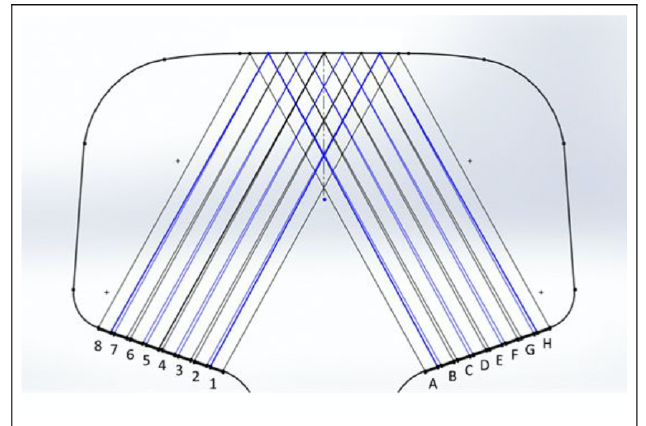
Figure 11. Pitch-catch ultrasonic measuring technique: The pulsers are labelled 1–8 from the inner bound to the outer bound, and the receivers are correspondingly labelled A to H.